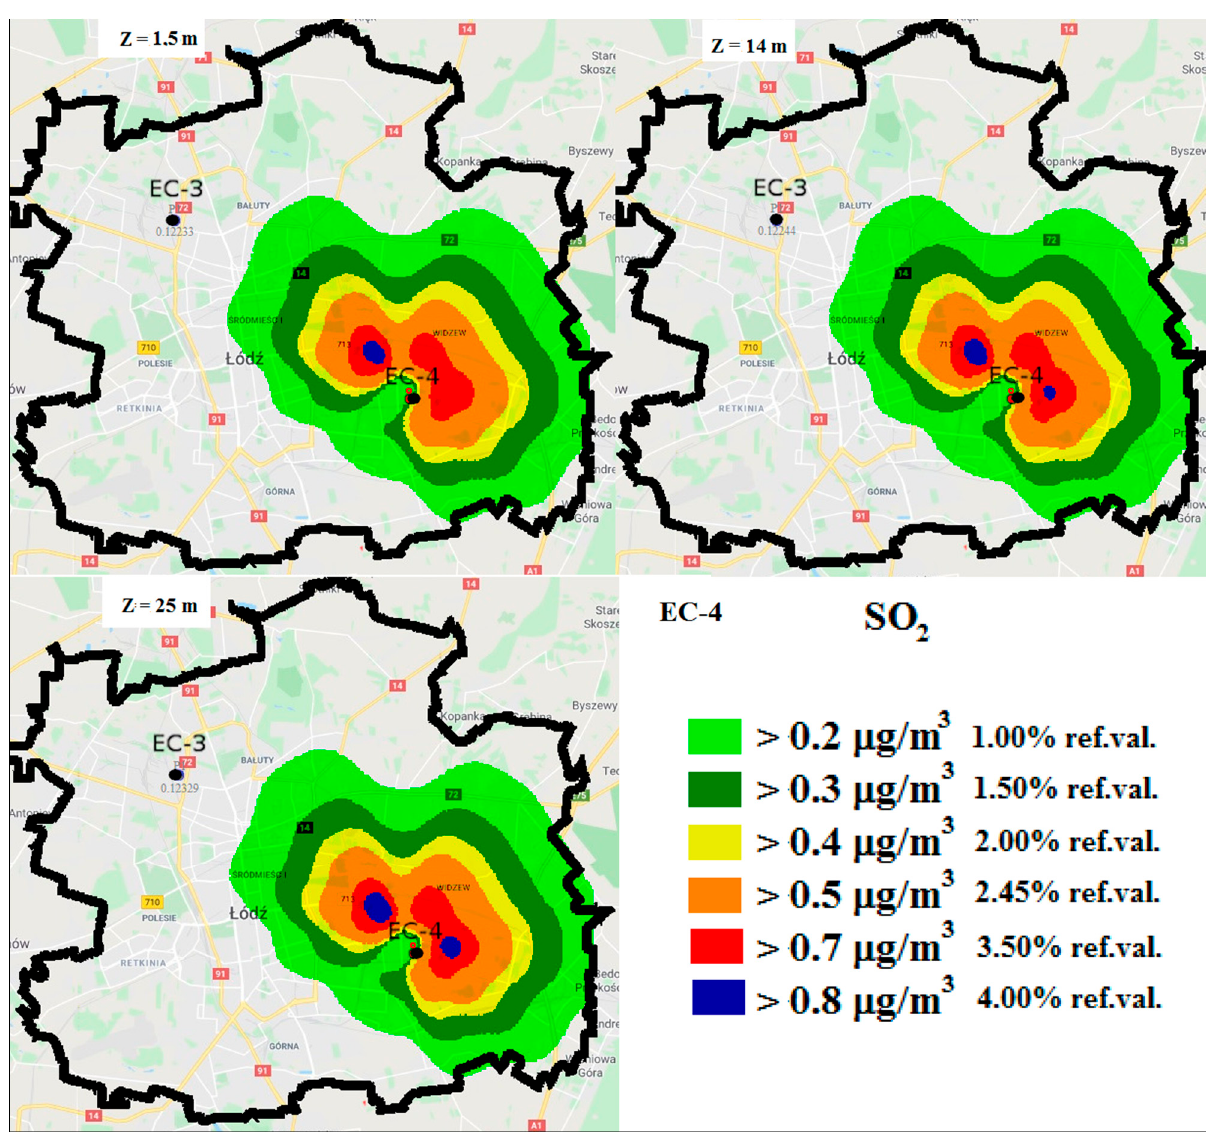
Figure 7. Distribution of annual average SO2 concentrations of 1.5 m, 14 m, and 25 m surrounded by EC-4 in 2019 based on the results from OPA03.